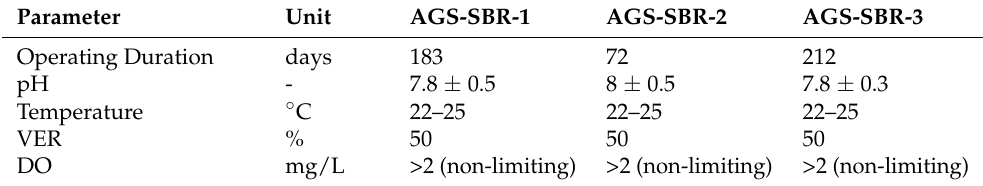
Table 2. Summary of operating conditions for aerobic granular sludge SBR systems.